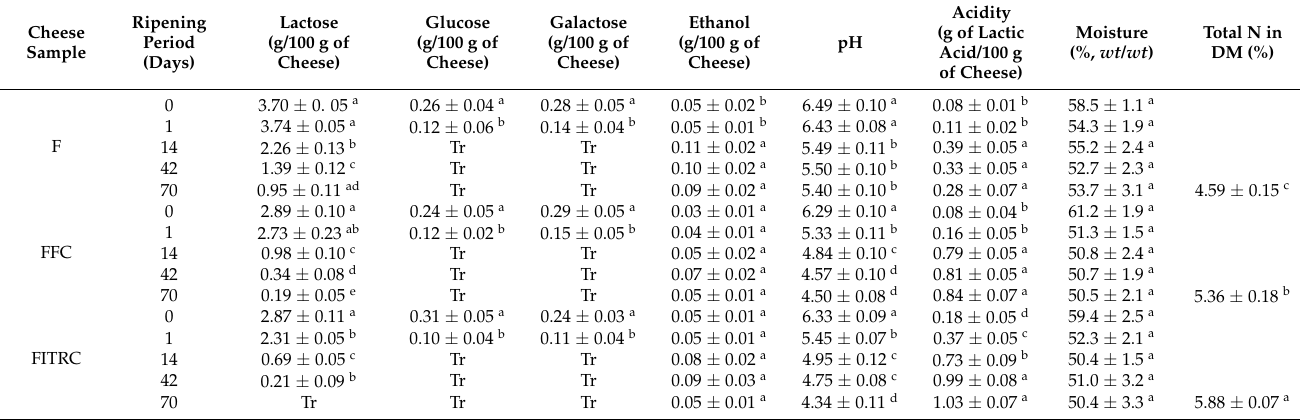
Different superscript letters in a column indicates statistically significant differences (ANOVA, Tukey’s HSD multiple range test, p < 0.05); Tr = trace; F = white brined cheese with no starter culture; FFC = white brined cheese produced with free L. paracasei SP5; FITRC = white brined cheese produced with immobilized L. paracasei SP5 on